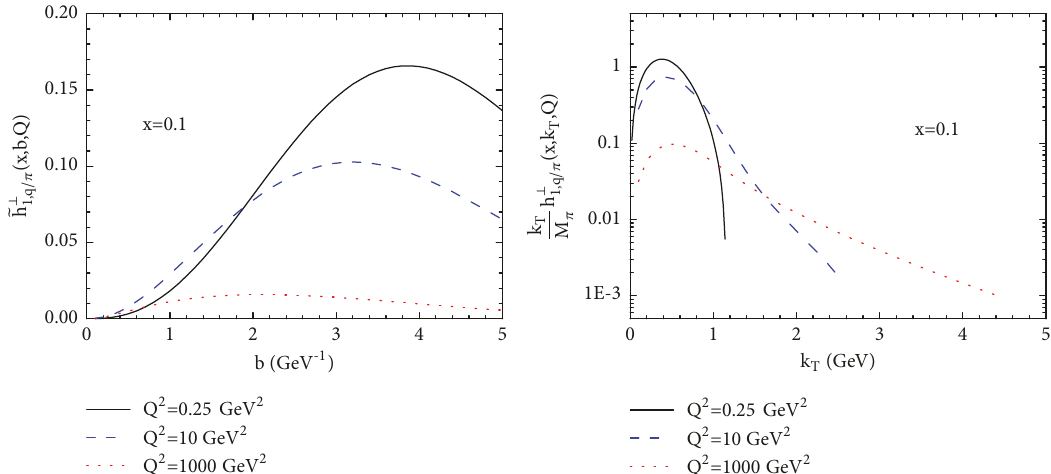
Figure 4: The Boer-Mulders function for 𝑢 -quark in 𝑏 space (left panel) and 𝑘 𝑇 space (right panel) considering three different energy scales: 𝑄 2 = 2.4 GeV 2 (solid lines), 𝑄 2 = 10 GeV 2 (dashed lines), and 𝑄 2 = 1000 GeV 2 (dotted lines). Figures from [61].